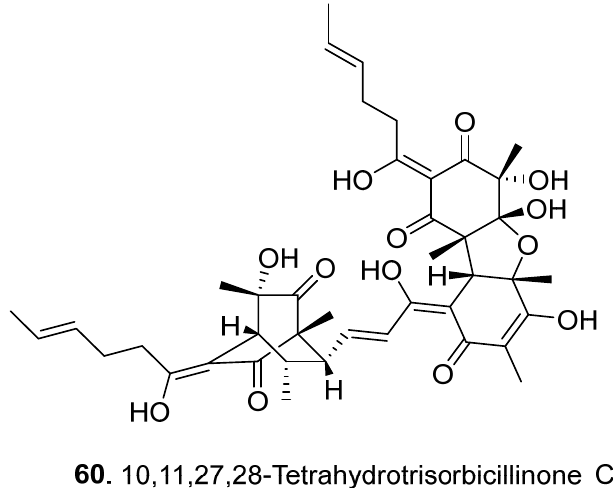
Figure 4. Structure of the trisorbicillinoid ( 60 ) isolated from fungi.